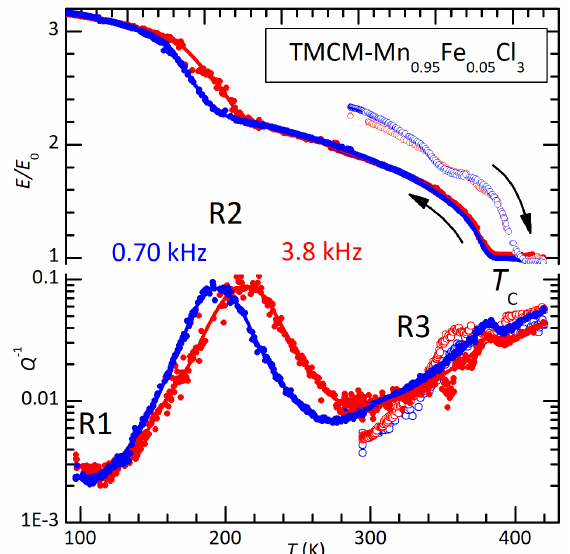
Figure 5. Normalised Young’s modulus E / E 0 = ( f / f 0 ) 2 and elastic energy loss coefficient Q − 1 of Sample B3 of TMCM-Mn 0.95 Fe 0.05 Cl 3 measured during heating and subsequent cooling, exciting the 1st and 3rd flexural modes, whose frequencies at high temperature are indicated. The labels R n indicate the thermally activated relaxations that were observed also in the dielectric